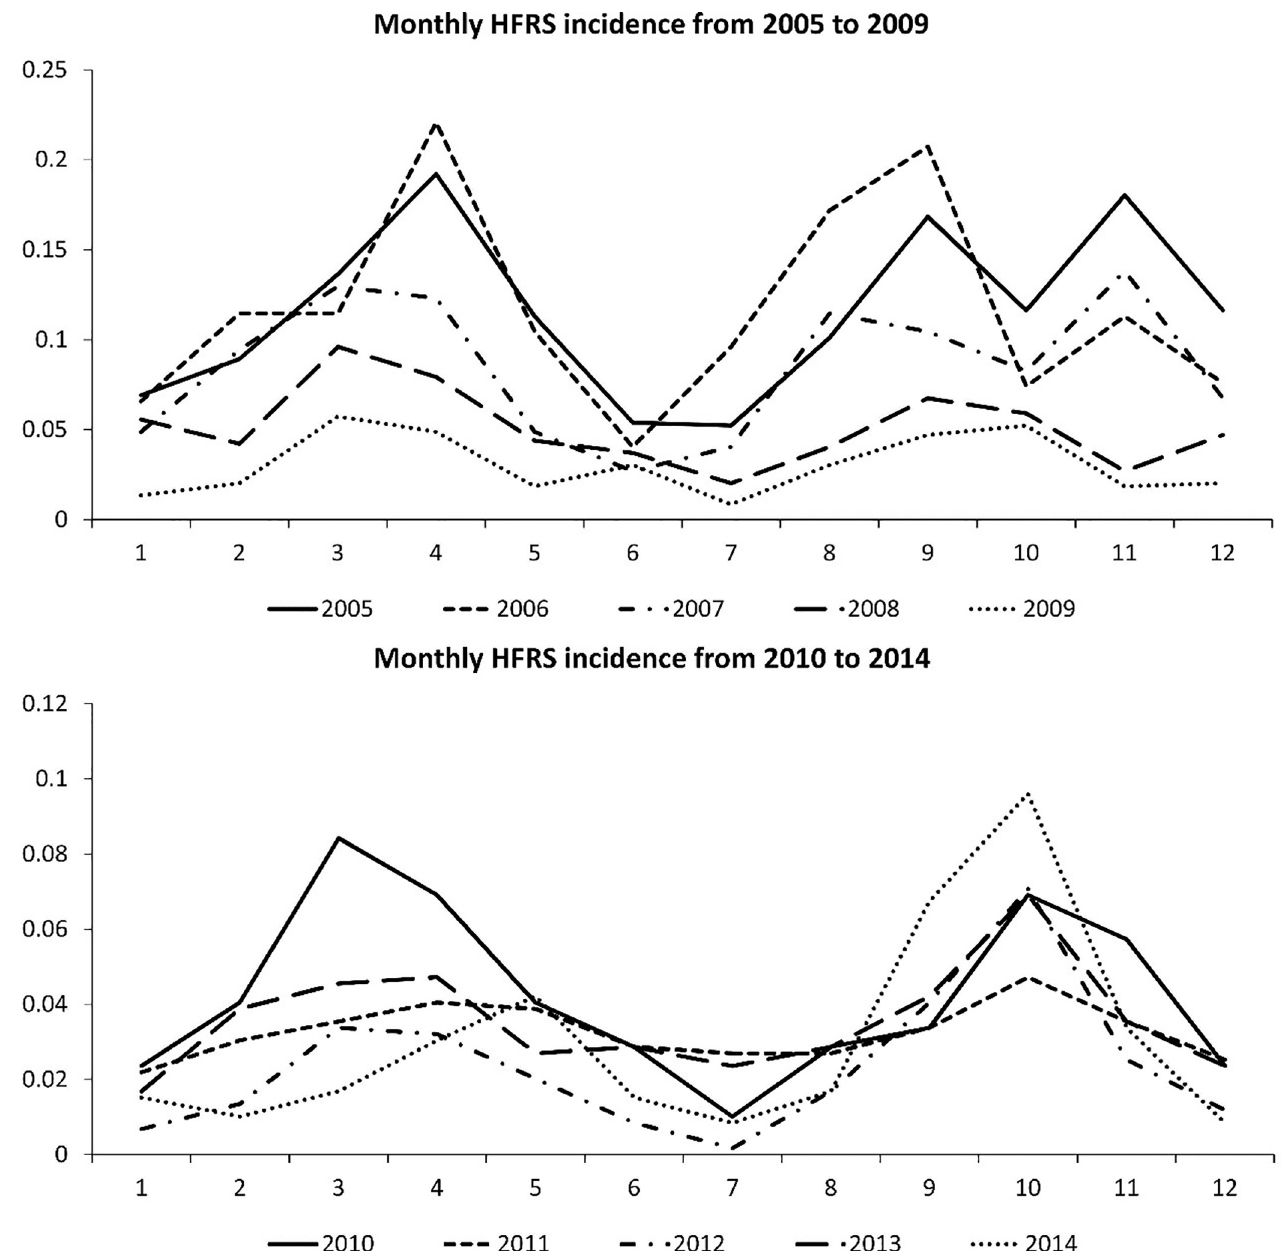
Fig 1. Monthly HFRS incidence from 2005 to 2014. (A) Average monthly HRFS incidence from 2005 to 2009. (B)Average monthly HRFS incidence from 2010 to 2014.